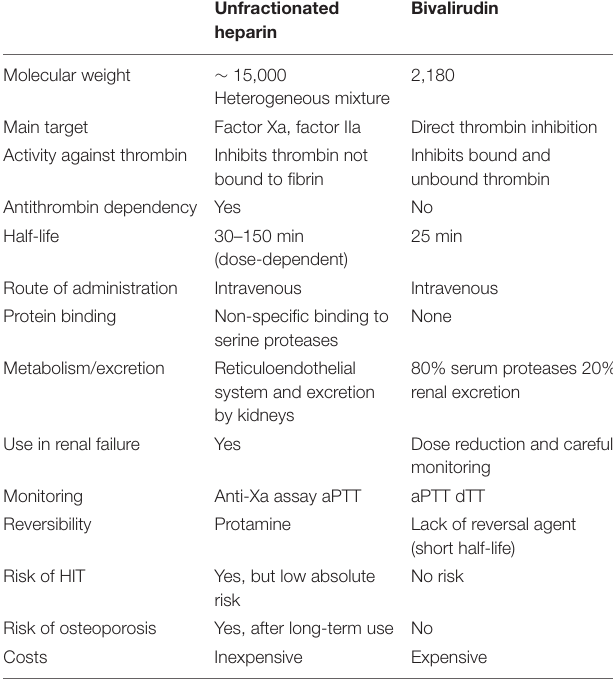
TABLE 1 | Features of unfractionated heparin and